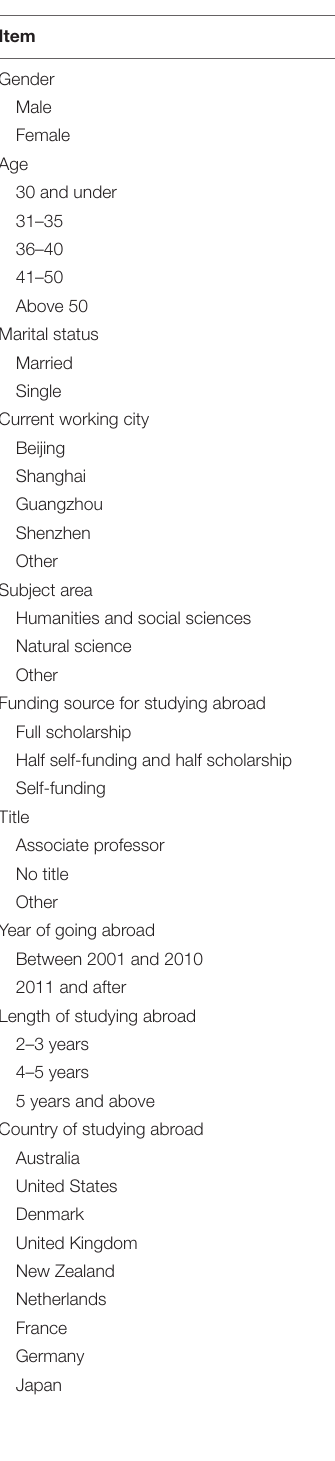
TABLE A1 | Participant CROPs’ demographic